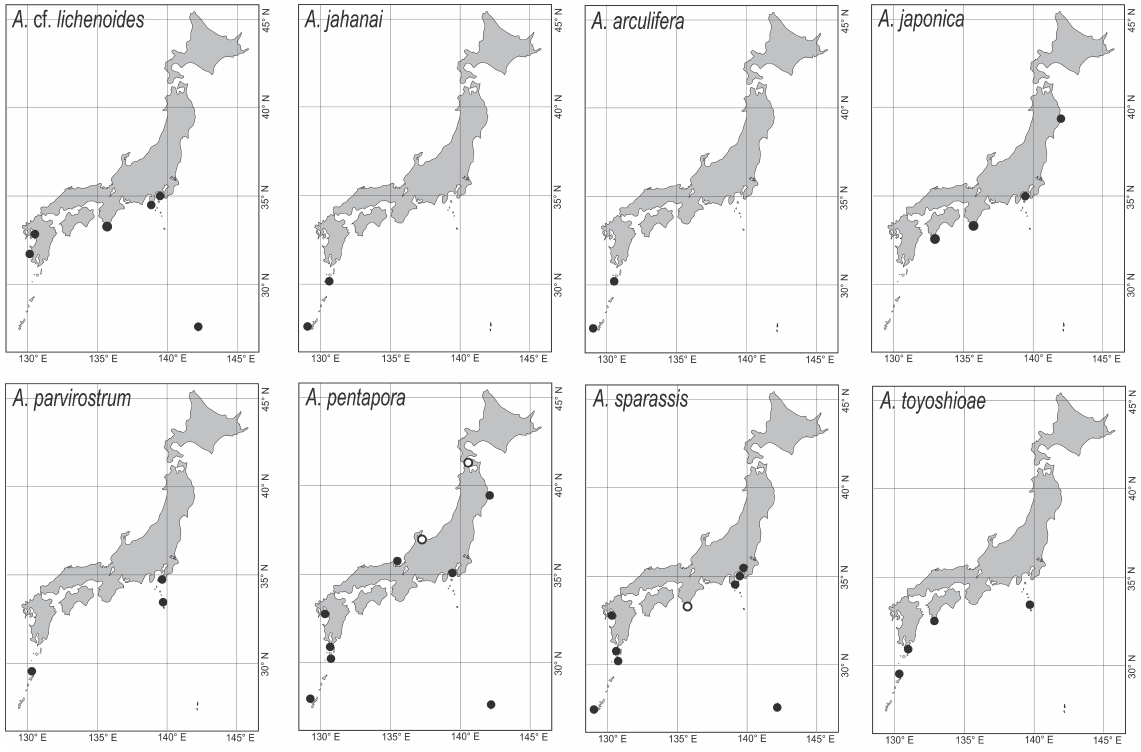
Fig. 18. Maps showing the distribution of the eight adeonid species in Japanese waters. solid circles indicate sites where a species was detected in this study and unfilled circles indicate records from Canu & Bassler (1929) and sakakura (1935) for A. pentapora Canu & Bassler, 1929, okada (1920) and Mawatari (1952) for A. sparassis ortmann, 1890, and okada & Mawatari (1935) for A. japonica ortmann,